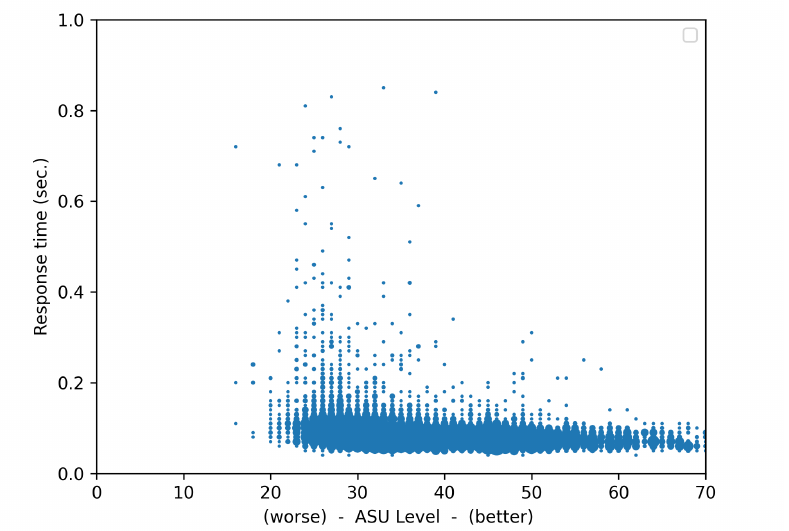
Figure 10. Relation between response time and signal power. The data correspond to the accumula- tion of several trips (13,098 messages in